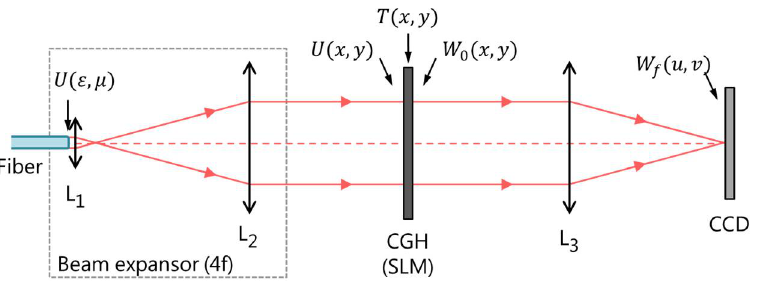
Figure 1. Scheme of the modal decomposition setup. L 1 , L 2 , and L 3 are lenses. SLM is the spatial light modulator where the CGH is implemented. U ( ε , µ ) is the waveguide output electric field, U ( x,y ) is the electric field at the CGH plane after passing through the beam expansor in a 4f configuration, T ( x,y ) is the SLM transmittance, W 0 ( x,y ) is the electric field after the SLM, and W f ( x,y ) is the electric field at the CCD camera plane.